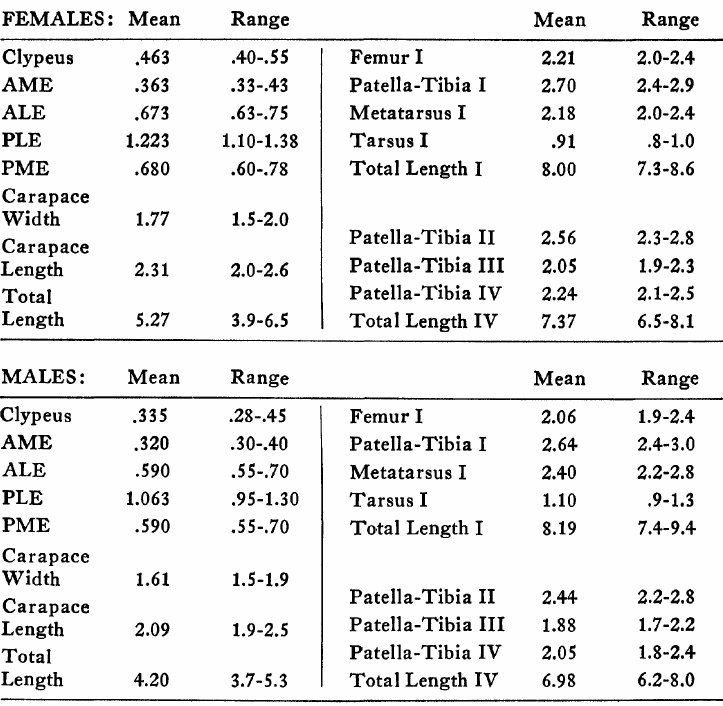
Color. Female. Face and chelicerae yellow to pale orange with darker brownish or black stripes as illustrated in Figure 3. Eye.s surrounded with black, overlaid with white spatulate-shaped hair. Lower edge o1: clypeus white to pale cream. Carapace yellow to pale orange with dark brown hairs forming pattern as illustrated in Figure 4. Dorsum ot: abdomen white to pale yellow, bordered by dark brown as in Figure 4. Vent’er white to pale yellow, speckled with brown. Legs yellow to pale orange with irregul, ar dusky spots, most con- spicuous ventrally. Labium cream to pale orange. Endites cream to pale orange, out- lined with dark brown, Sternum white to pale yellow, with dark brown